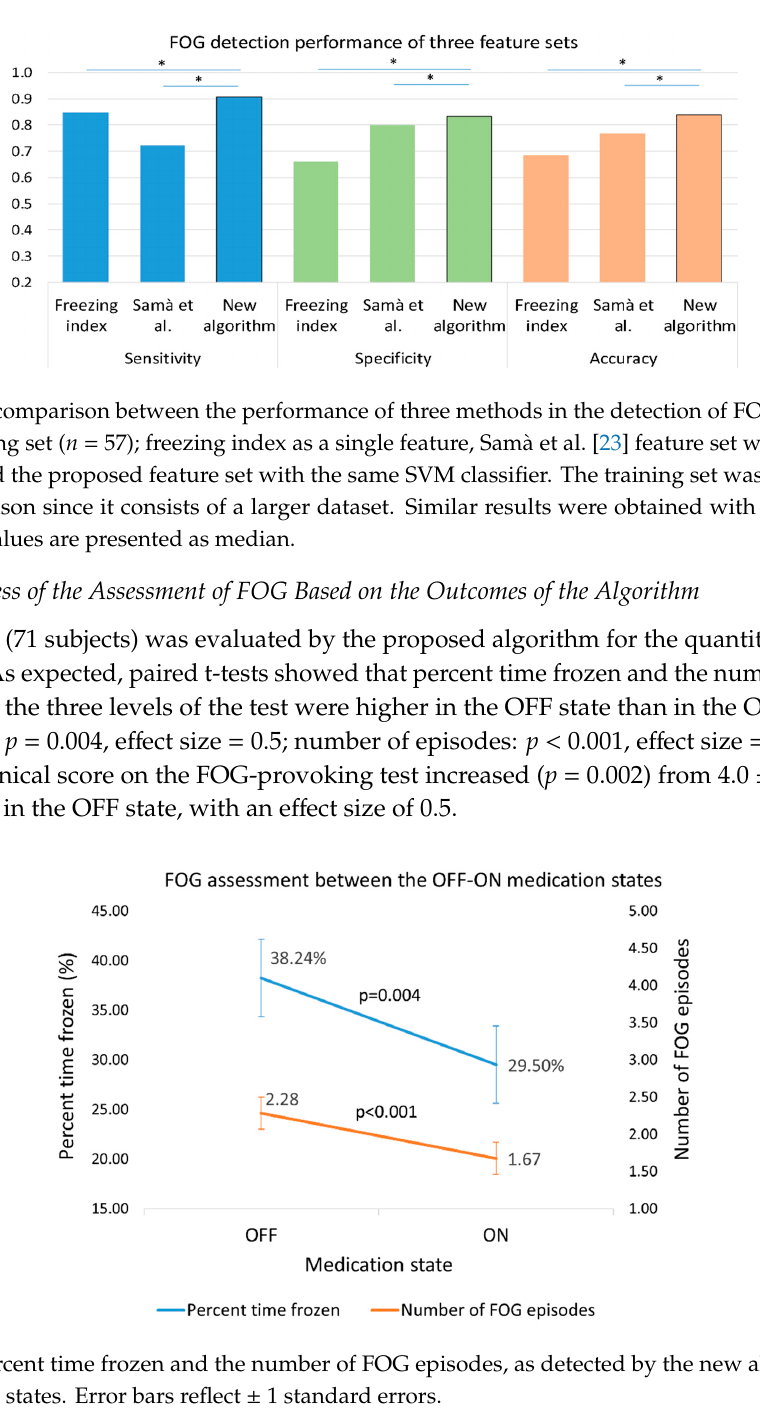
Table 4. FOG outcomes determined by using the automated algorithm differ in between the easiest and most challenging levels of the test within OFF–ON states.